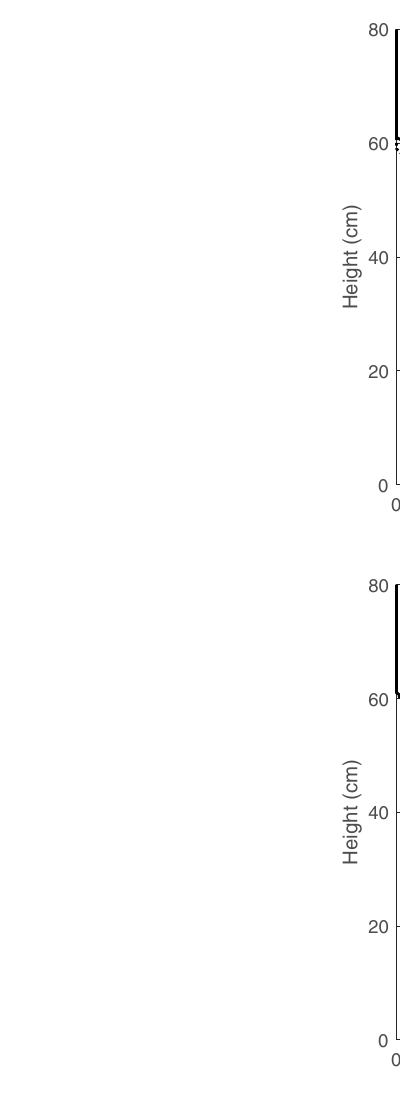
FIGURE 11 Variation of normalized CVP for two directions of travel (A) parallel to (or with) the rows and (B) perpendicular to (across) the